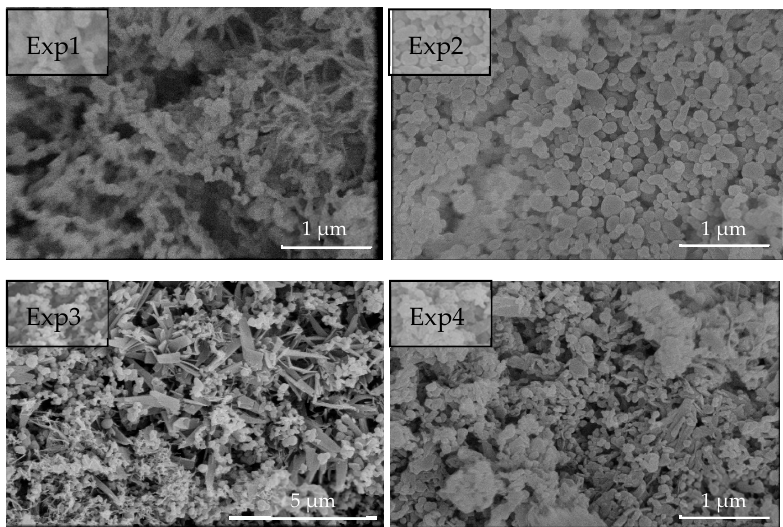
Figure 4. SEM images for deposition experiments 1–4.